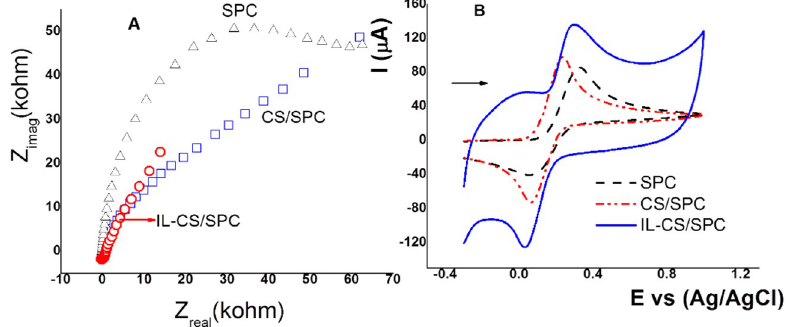
10.0 mmol L −1 in KCl 10 mmol L −1 using SPC (dash curve), CS/SPC (dash‐dot curves) and IL‐CS/SPC 10.0 mmol L − 1 in KCl 10 mmol L − 1 using SPC (dash curve), CS/SPC (dash-dot curves) and